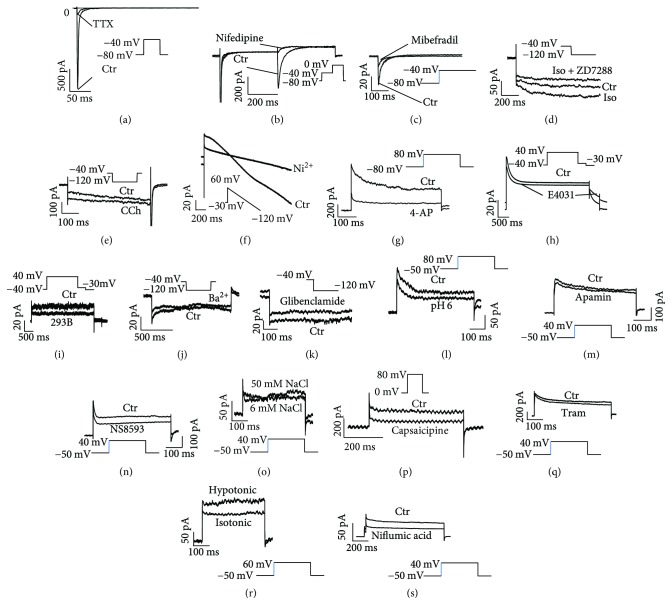
Ion channel currents in hiPSC-CMs. Whole currents were evoked by the indicated protocols, respectively. Specific blockers or solutions were applied to confirm the identity of expected currents. (a) Representative traces of TTX- (20 μM) sensitive peak INa. (b) Representative traces of nifedipine- (1 μM) sensitive ICa-L. (c) Representative traces of mibefradil- (10 μM) sensitive ICa-T. (d) Representative traces of ZD7288- (30 μM) sensitive If. (e) Representative traces of CCh- (10 μM) activated IKACh. (f) Representative traces of Ni2+- (5 mM) sensitive INCX. (g) Representative traces of 4-AP- (3 mM) sensitive Ito. (h) Representative traces of E-4031- (3 μM) sensitive IKr. (i) Representative traces of chromalol 293B- (10 μM) sensitive IKs. (j) Representative traces of Ba2+- (100 μM) sensitive IK1. (k) Representative traces of glibenclamide- (10 μM) sensitive IKATP. (l) Representative traces of pH- (6.0) sensitive potassium channel current. (m) Representative traces of apamin- (100 nM) sensitive ISK1–3. (n) Representative traces of NS8593- (10 μM) sensitive ISK1–3. (o) Representative traces of Na+- (50 mM) sensitive IKNa. (p) Representative traces of capsaicipine- (100 μM) sensitive TRPV1 current. (q) Representative traces of TRAM 34- (100 nM) sensitive ISK4. (r) Representative traces of hypotonic solution- (220 mOsm/L) activated ICl-vol. (s) Representative traces of niflumic acid- (100 μM) sensitive ICl-Ca.